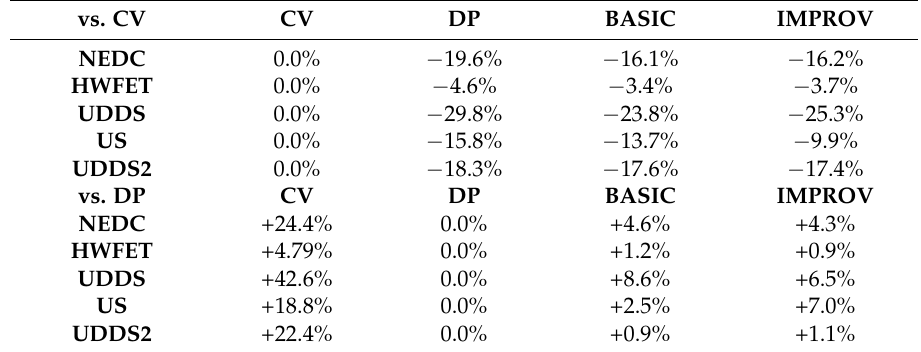
Table 4. Relative fuel consumption compared to the consumption of conventional fuel trucks (CV) and in relation to the consumption of HHV whose variables are optimized by the DP algorithm (DP). vs. CV CV DP BASIC